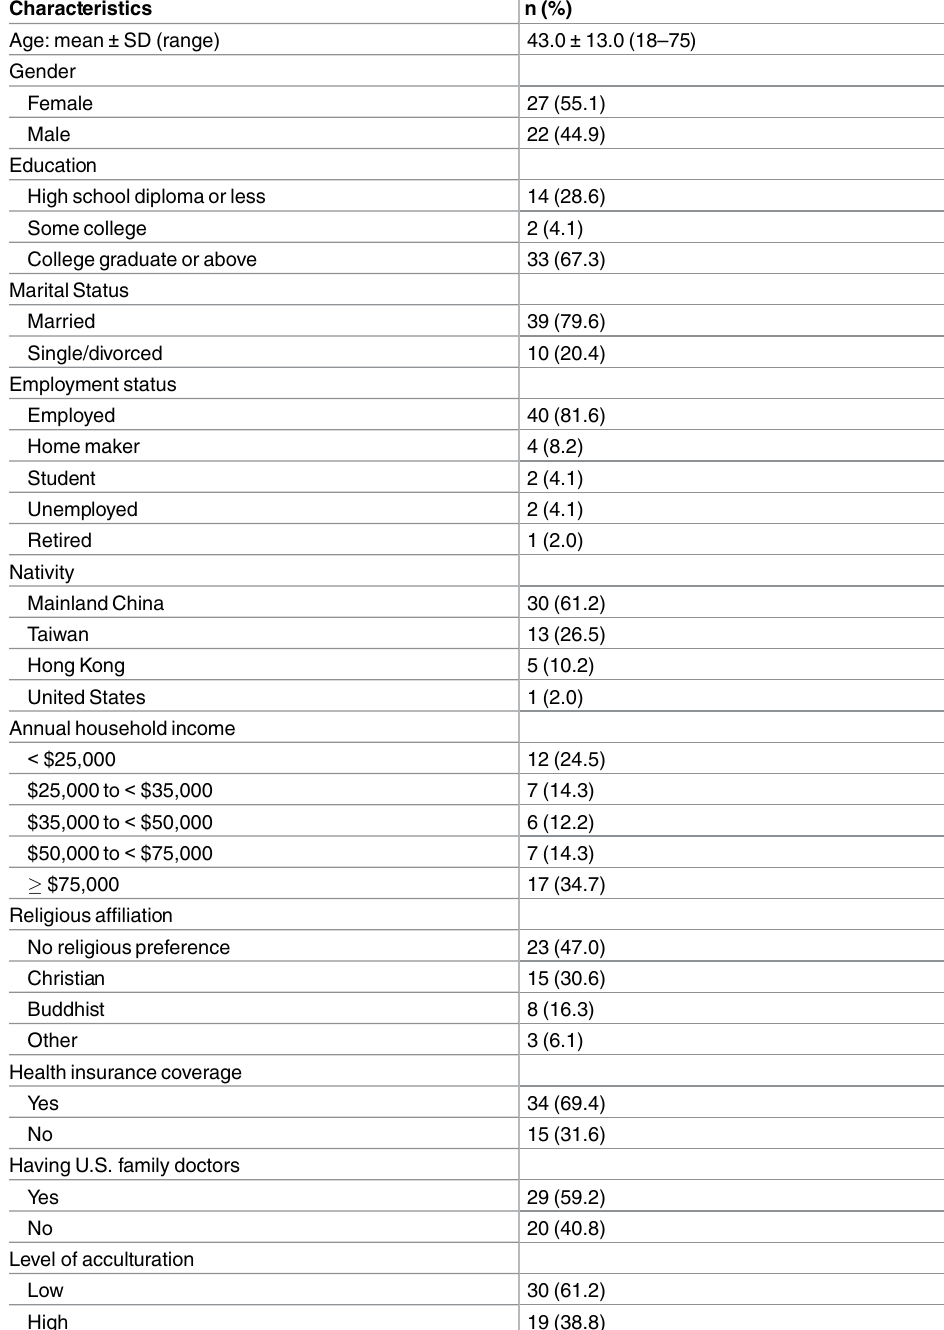
Table 1. SampleCharacteristicsof 49